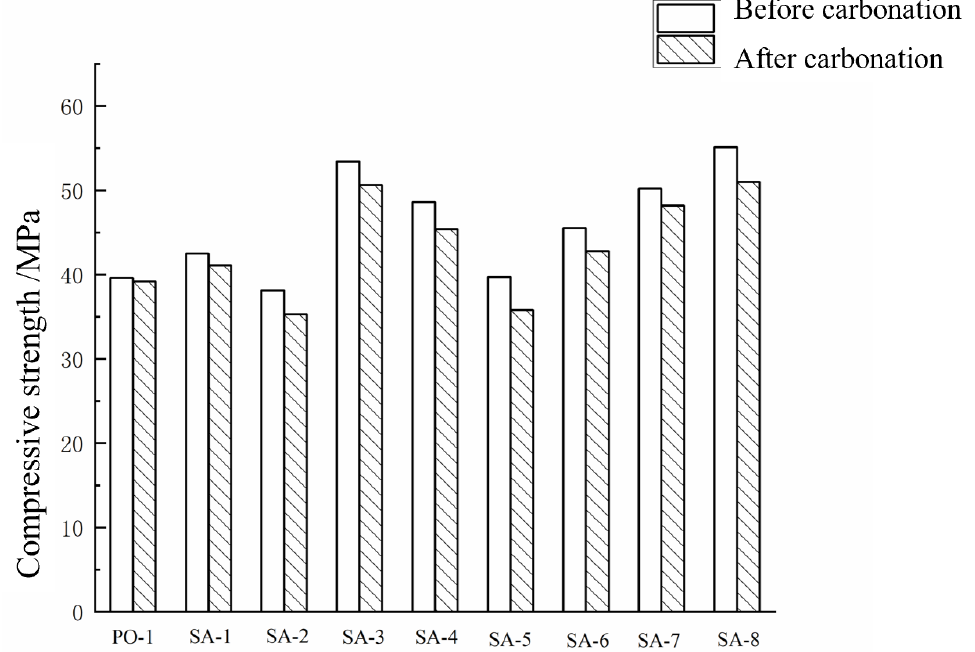
Figure 4. Compressive strength of cement paste before and after carbonation. Table 4. Loss rate of compressive strength of cement paste after